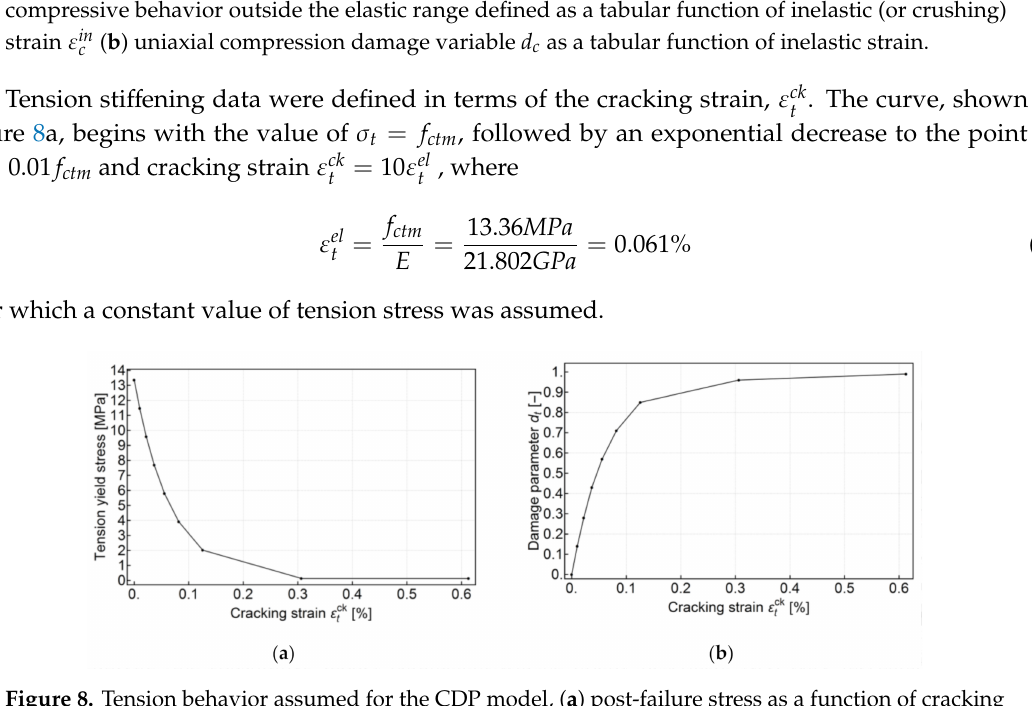
Figure 8. Tension behavior assumed for the CDP model, ( a ) post-failure stress as a function of cracking strain ε ck , ( b ) uniaxial tension damage variable d t as a tabular function of cracking t